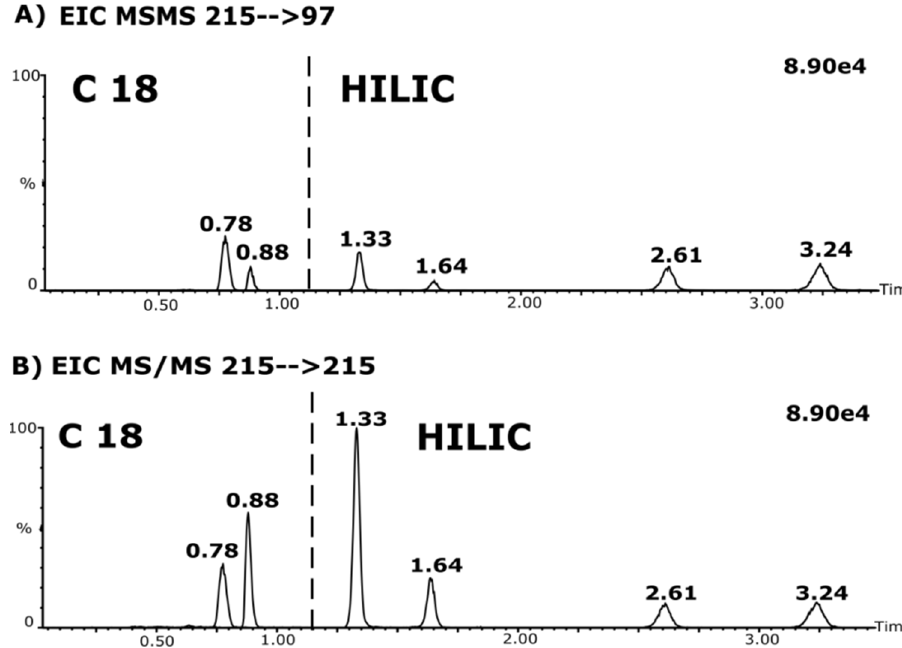
Figure 5. GC/MS chromatograms illustrating the power of reversed-phase C18 HPLC and HILIC for separating MW 216 methyltetrol sulfates (i.e., extracted ion chromatograms for the m / z 215/97 ion pair ( A ) and 215/215 ion pair ( B )) The chromatograms obtained in both modes were overlain on one graph and normalized to compare their relative intensities. The vertical dashed line separates the chromatograms that were obtained with different methods. Two isomers are detected in the C 18 reversed-phase mode, while four of the six isomers are observed in the HILIC mode (reprinted with permission from Spólnik et al., 2018 [46]; copyright (2018) American Chemical Society).